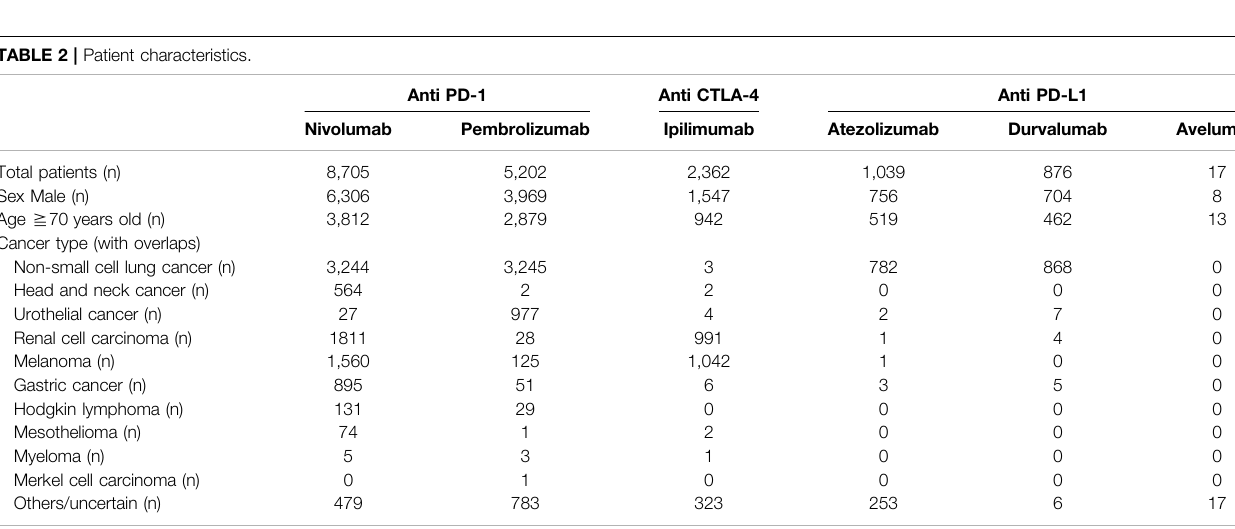
TABLE 2 | Patient